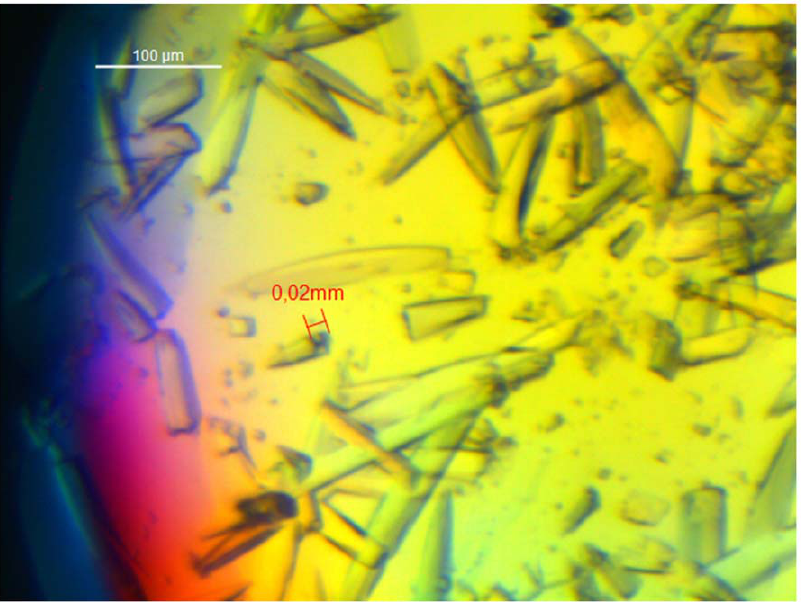
Figure 1. Micrograph of crystals of mAb04c under polarized light. 3 m l microbatch. Conditions: 1.5 m l 20 mg/ml mAb04c in 20 mM Tris, 50 mM Histidine, pH 7 plus 1.5 m l 12% (w/v) PEG 8000, 0.4 M calcium acetate in 0.2 M Imidazol, pH 7, RT. The broken crystal (intentionally) indicates that the dimension of crystal is about 100 , 150 m m 6 10 , 20 m m 6 10 , 20 m m.